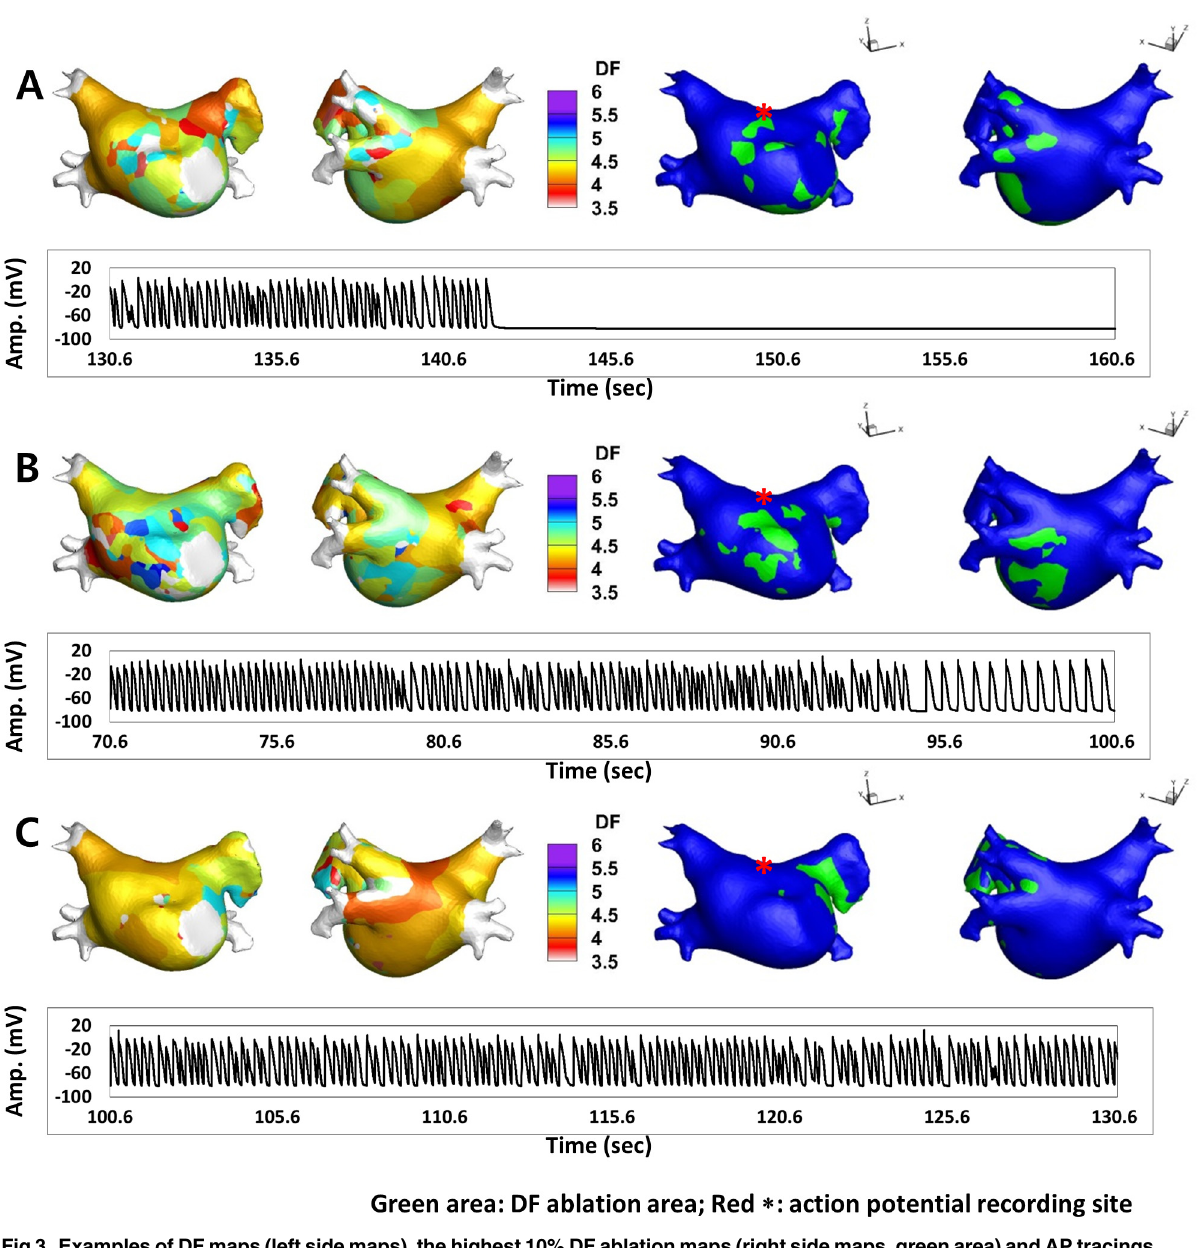
Fig 3. Examples of DF maps (left side maps), the highest 10% DF ablation maps (right side maps, green area) and AP tracings acquired from the LA roof top (red asterisk) after virtual DF ablation. A. AF was terminated at 142.2 seconds (11.6 seconds after virtual ablation of the high DF area). B. During DF ablation, AF changed into AT at 95.0 seconds (24.4 seconds after virtual ablation). C. The wave dynamics of AF did not change during DF